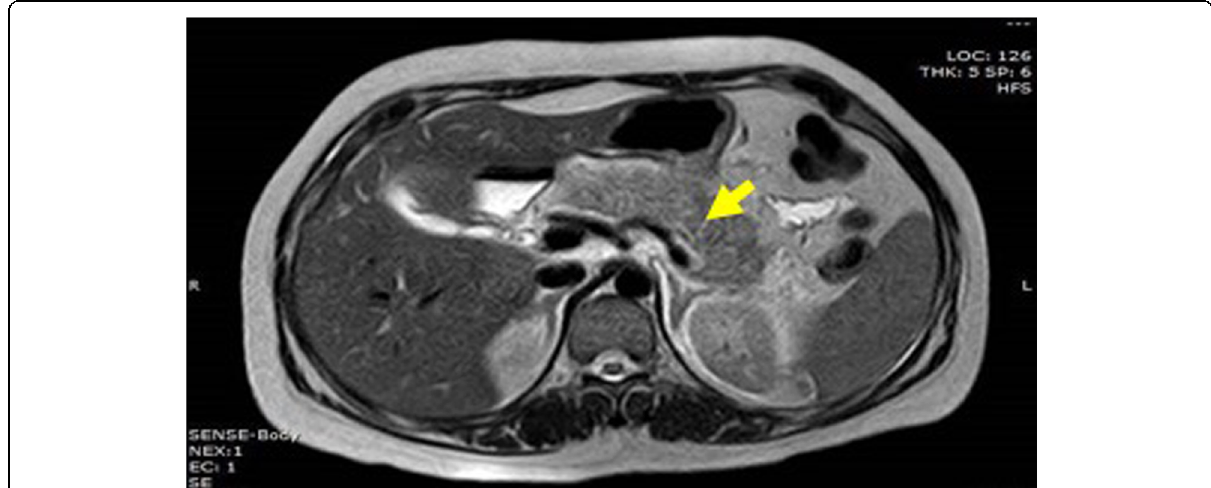
Fig. 6 Axial T2WI shows edematous pancreas (yellow arrow) with minimal peripancreatic fluid